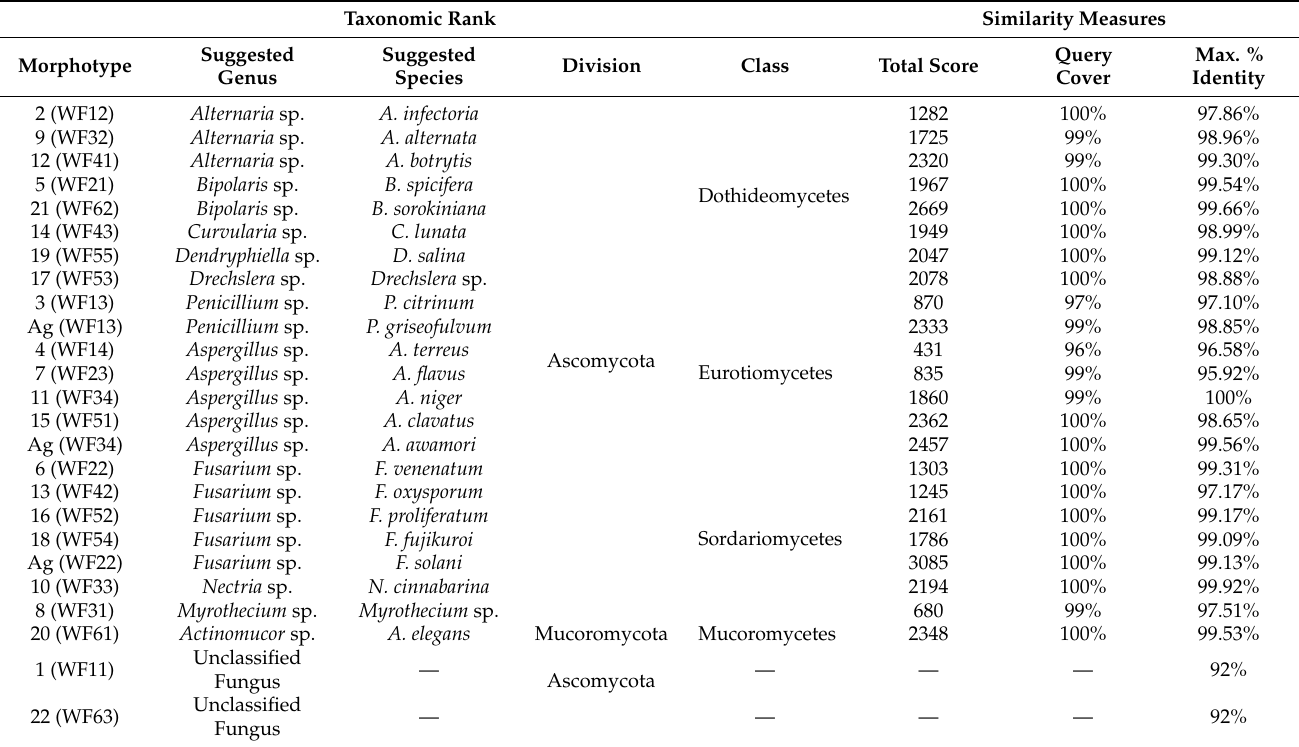
Table 2. A key table showing taxonomical analysis and similarity measures (using ITS rRNA gene) of the endophytic fungal morphotypes isolated from the six wild stress-tolerant plant